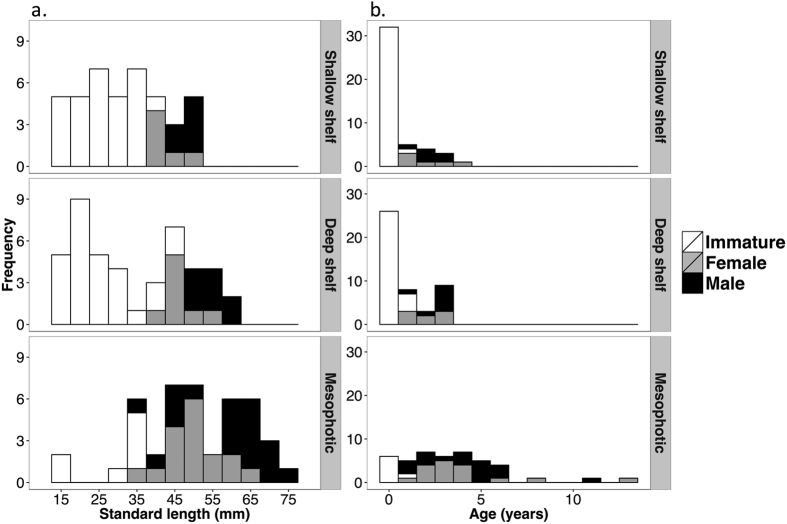
Frequency distributions of Stegastes partitus (a) standard length (mm) and (b) otolith-derived age (years) from transect collections at shallow shelf (SS) and deep shelf (DS) strata, and a random selection of fish from the mesophotic (MP) stratum. The gray scale indicates maturity and sex. MP size and age distributions were significantly different (p < 0.05, see Table 1 for detailed statistical results) than SS and DS distributions.